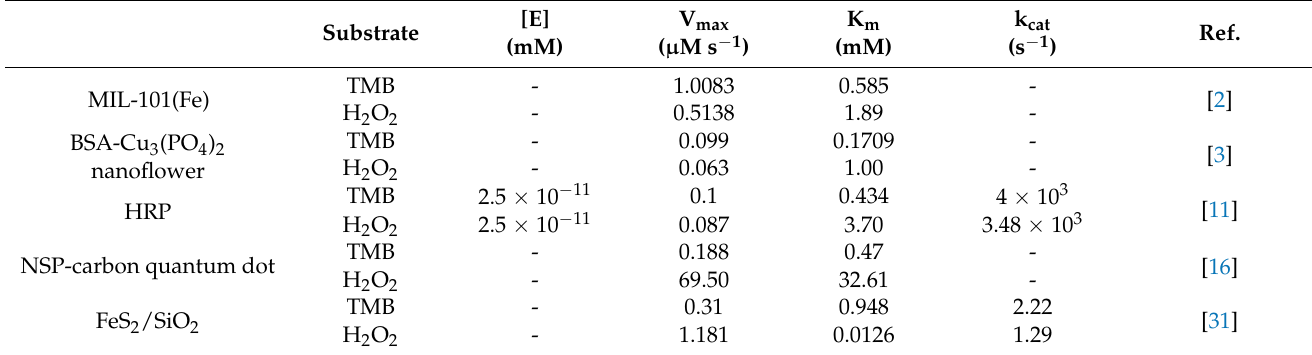
Table 1. Comparison of kinetic constants of His@MNPs, pristine MNPs, HRP, and other peroxidase-mimicking nanozymes with H 2 O 2 and TMB. K m is the Michaelis-Menten constant, k cat is derived from k cat = V max /[E], where V max is the maximal reaction velocity, and [E] is the iron concentration measured by ICP-AES.